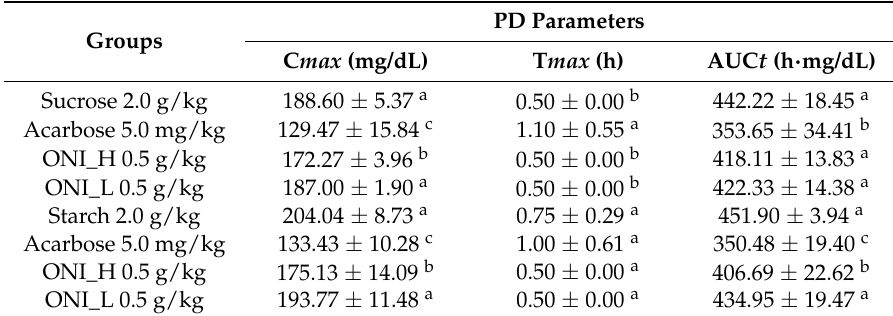
Table 3. Changes in pharmacodynamic (PD) parameters of control and after administration of ONI_H, ONI_L, and acarbose with sucrose or starch ingestions PD Parameters Groups